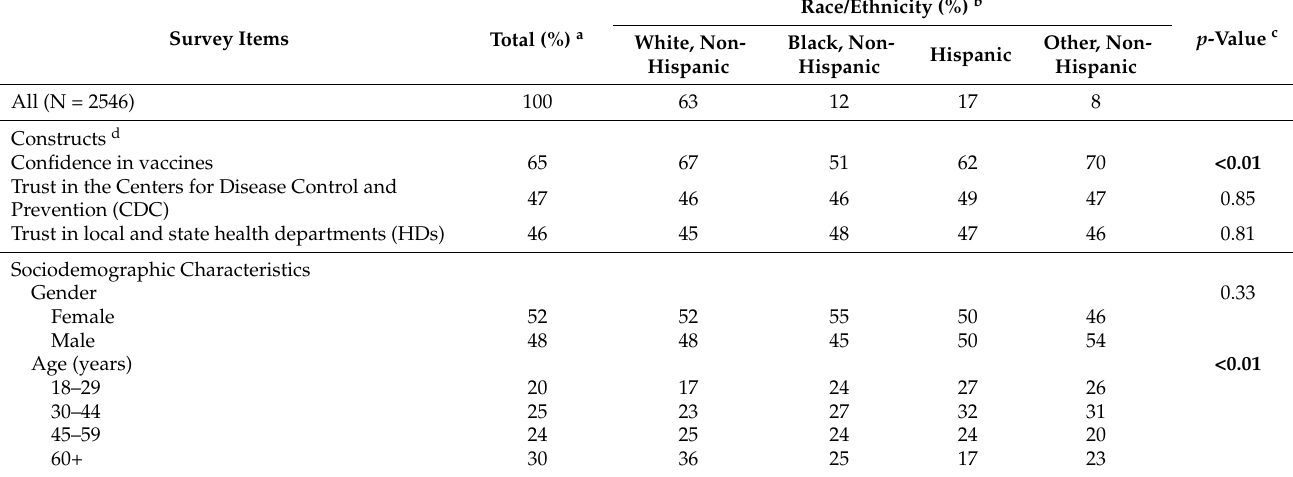
Table 4. Race/Ethnicity by Vaccine Attitudes, Trust in CDC and HDs, and Sociodemographic Characteristics. Numbers in the “Total” column indicate the percentage of the total weighted sample providing the September 2021 survey response in each row. Numbers in the “Race/Ethnicity” columns indicate the percentage of those whose race/ethnicity match that of the column header who provided the survey response in each row. The numbers in the final column indicate the p -value of this association, boldface indicating statistical significance ( p <